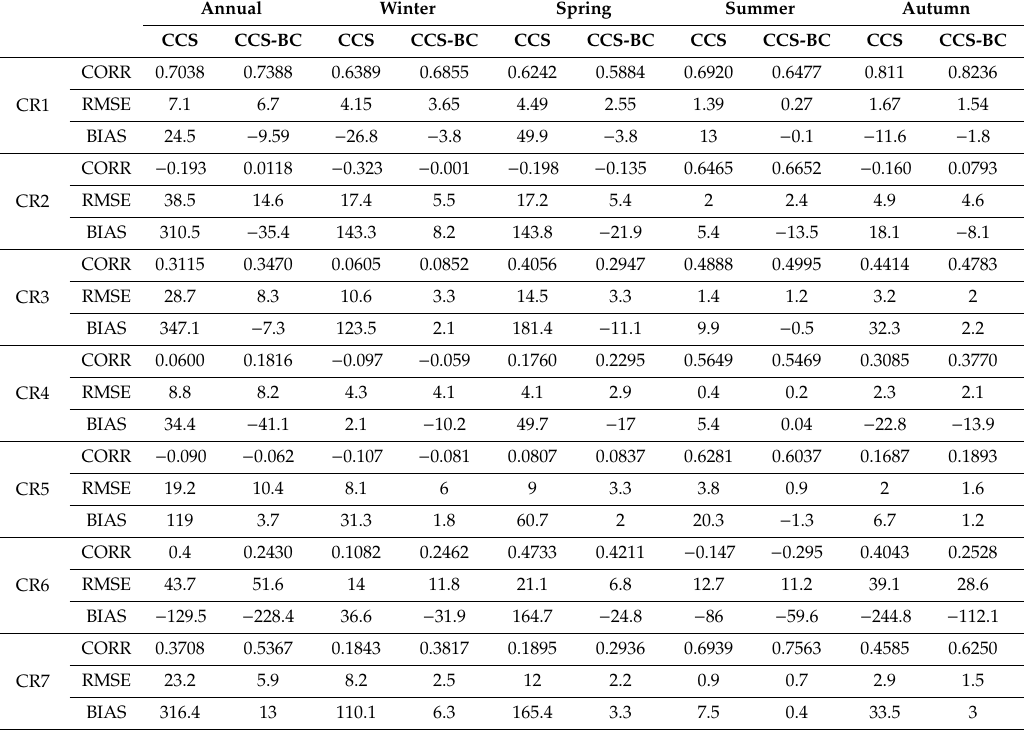
Figure 4. Scatter plots of the CCS and CCS-BC mean annual precipitation versus the gauge mean annual precipitation in gauged pixels for each CR for the calibration and validation periods. Table 2. Quantitative results of the spatial evaluations for the mean annual and mean seasonal precipitations of the CCS and CCS-BC compared to the gauge observations for the seven CRs for the calibration period. BIAS: mean bias, CORR: correlation coe ffi cient and RMSE: root mean square error.